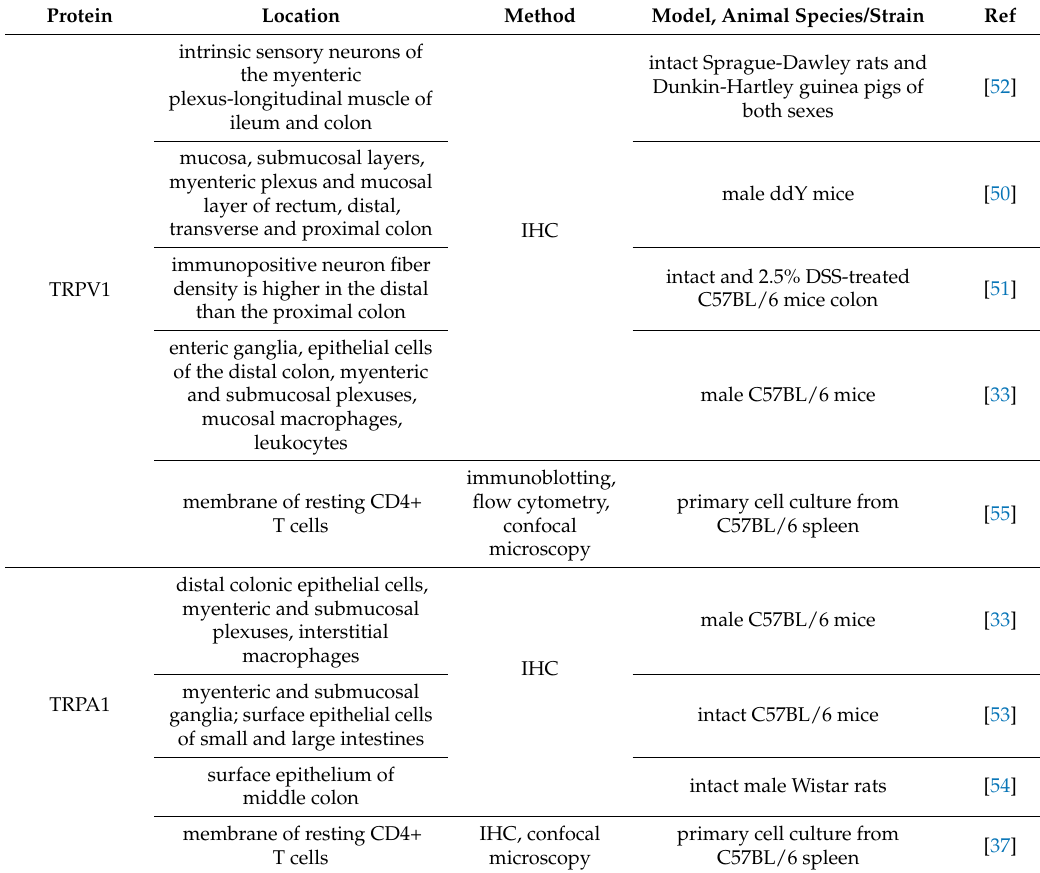
Table 4. Protein expression of TRPV1 and TRPA1 in the animal colon (IHC: immunohistochemistry).